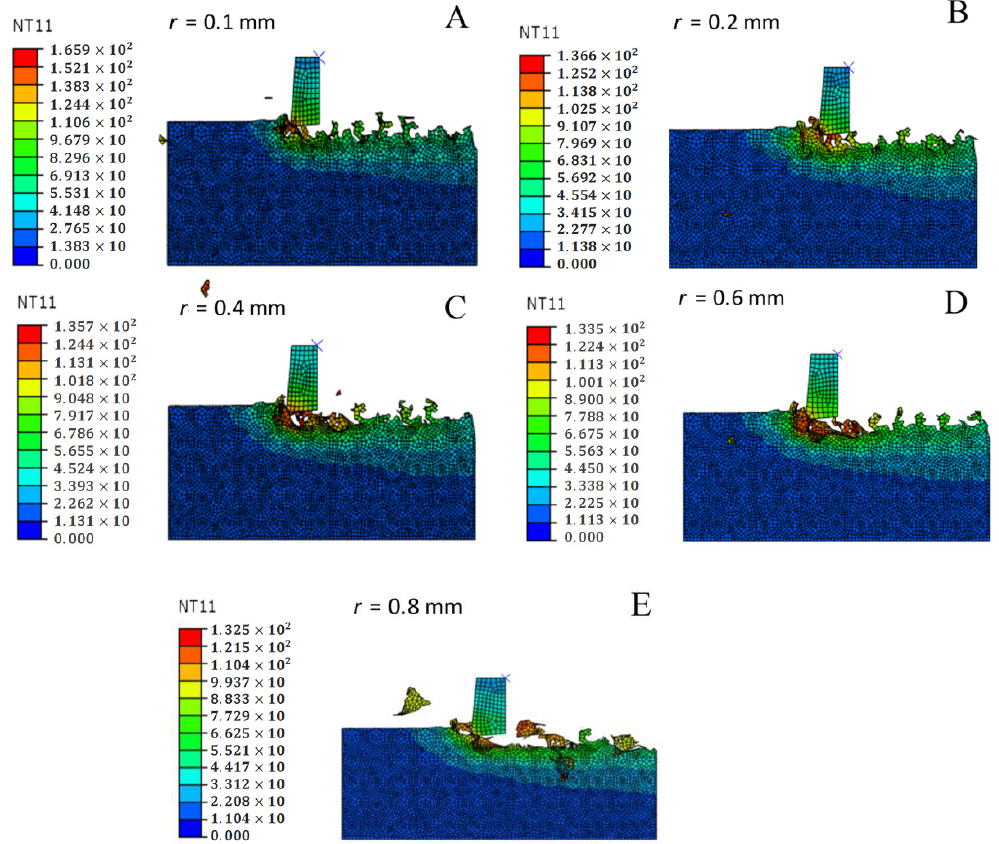
Figure 7. Cutting temperature nephogram with different corner radii. ( A ) r = 0.1 mm. ( B ) r = 0.2 mm. ( C ) r = 0.4 mm. ( D ) r = 0.6 mm. ( E ) r = 0.8 mm.